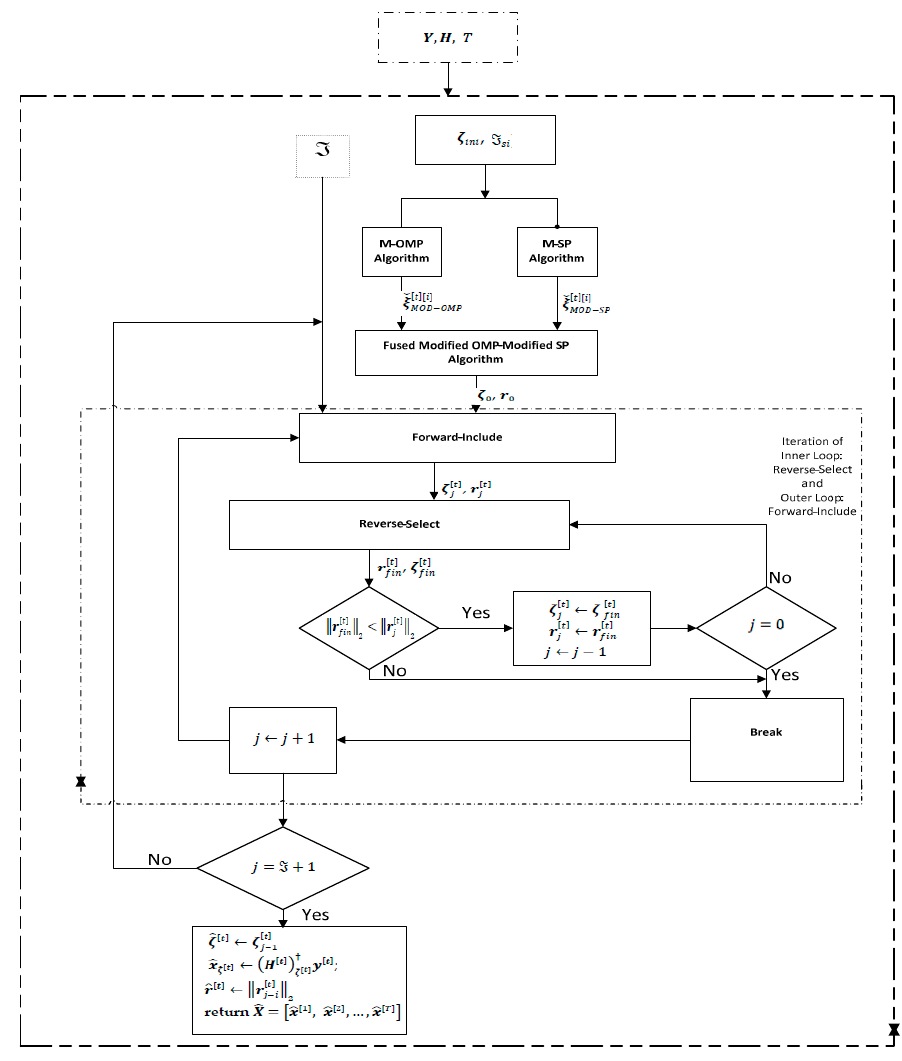
Figure A1. Block diagram of the FROMPUS-based MUD.